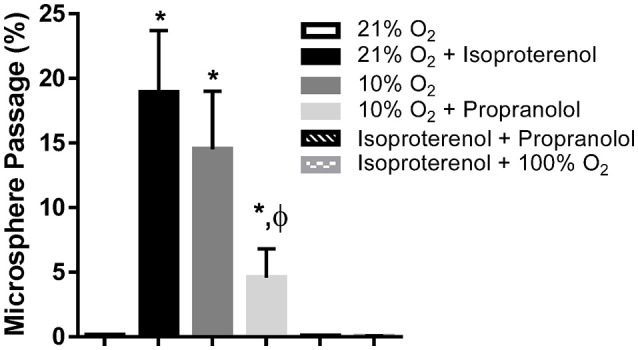
Percent transpulmonary passage of venous-injected microspheres in the intact rat. Data are presented as ordered in the legend. Hypoxia (10% O2) and isoproterenol infusion recruited intrapulmonary arteriovenous anastomoses (IPAVA), evidenced by an increase in the percent of venous-injected microspheres traversing the lungs and embolizing the liver. Propranolol pre-treatment minimized hypoxia- and isoproterenol-induced IPAVA recruitment. 100% O2 eliminated isoproterenol-induced IPAVA perfusion. *Indicates p < 0.05 compared to 21% O2 and ϕ indicates p < 0.05 compared to 10% O2.